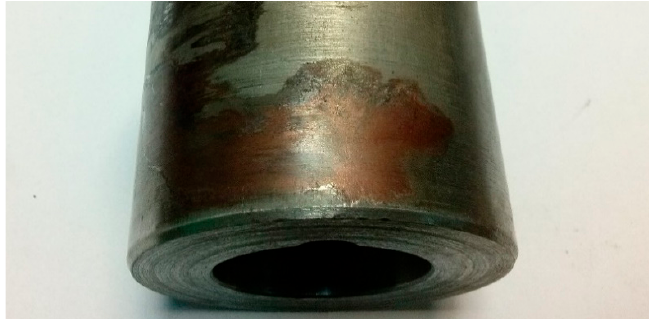
Figure 2. Damage to the outer surface of the shaft journal.